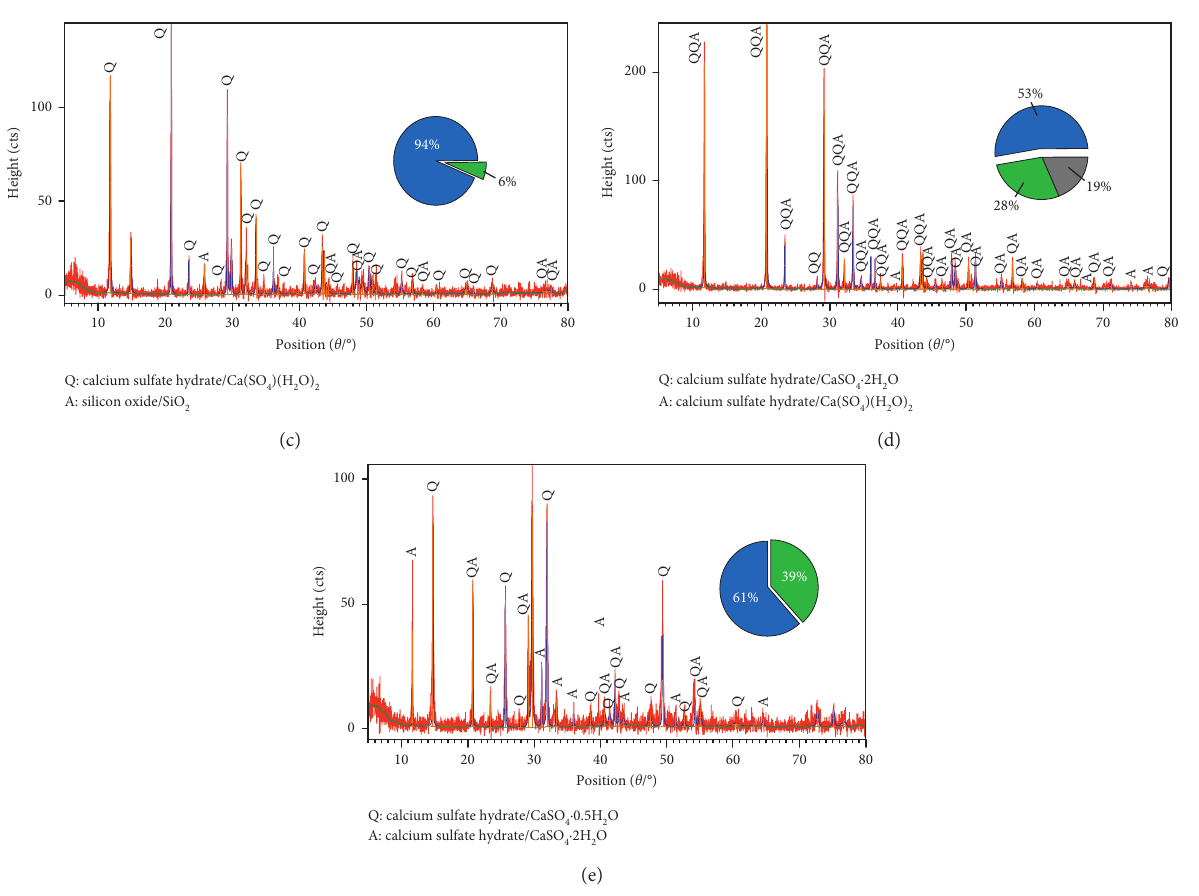
Figure 14: X-ray diffraction pattern of each group of samples. (a) Gypsum. (b) Natural sample. (c) Dehydrated sample at 45 ° C. (d) Water saturated sample. (e) High-temperature dehydrated sample at 220 °